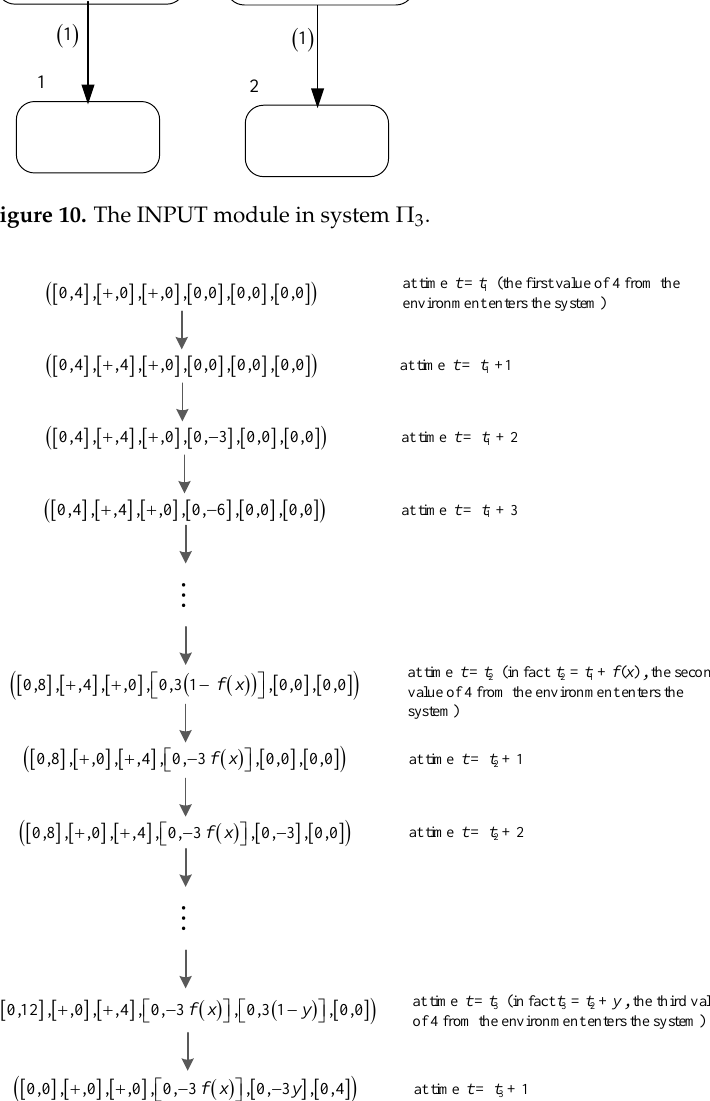
Π . Figure 11. Configuration dynamics of the INPUT module in system Π 3 3